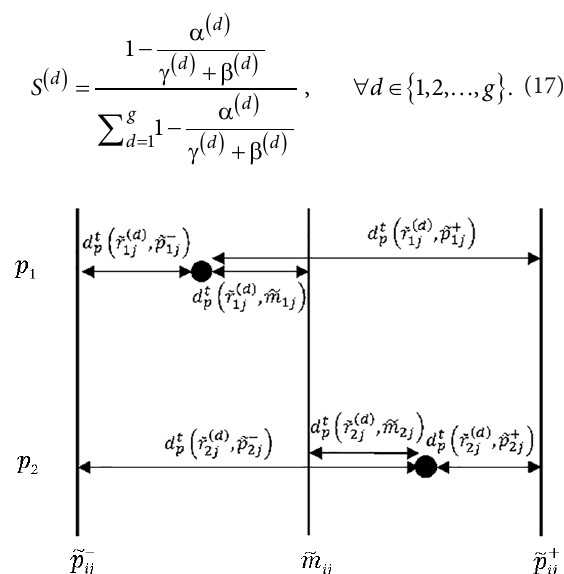
Figure 1. A variety of dispersion around the average matrix for two